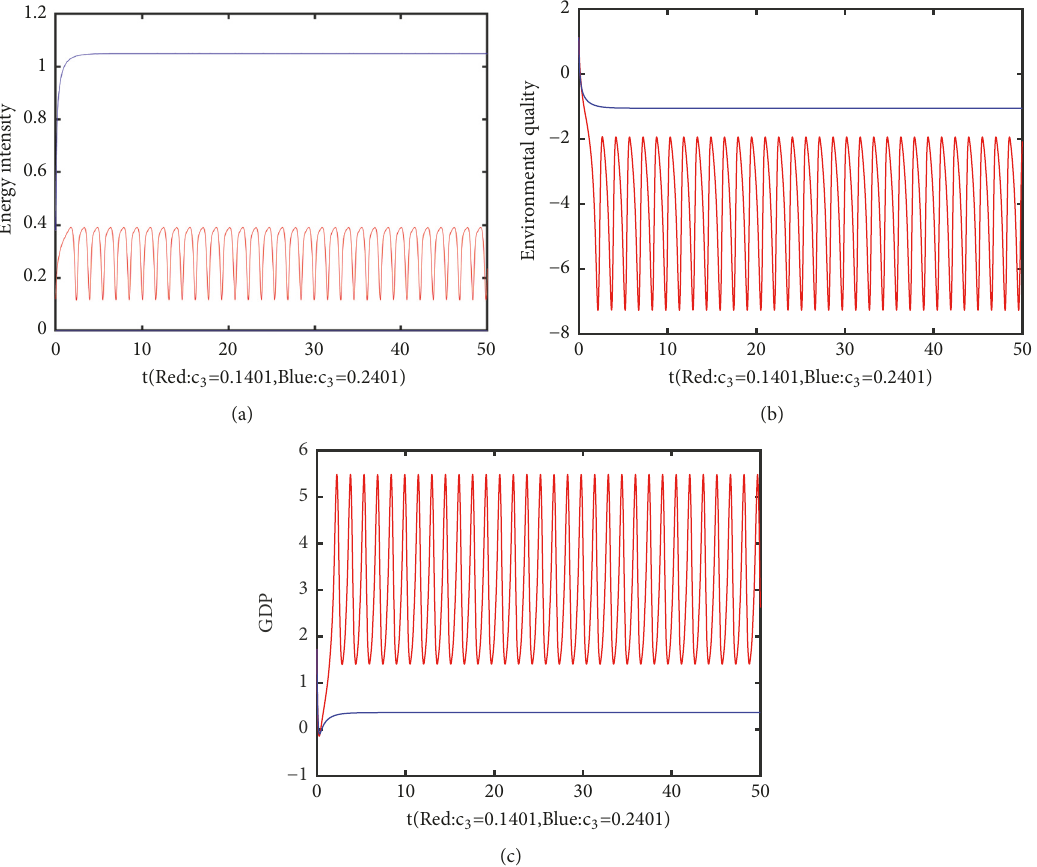
Figure 10: The influence of system (1) parameters 𝑐 3 on energy intensity and environmental quality: (a) energy intensity, (b) environmental quality, and (c)